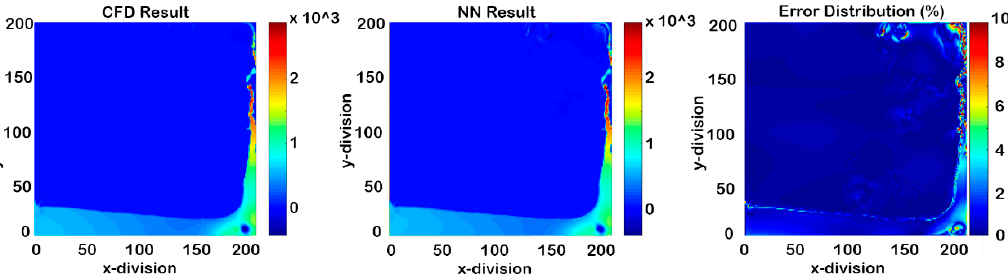
Figure 37. Cascading results of Model Ⅳ for phase fraction at time-step 1050 (50 time-steps after deployment).